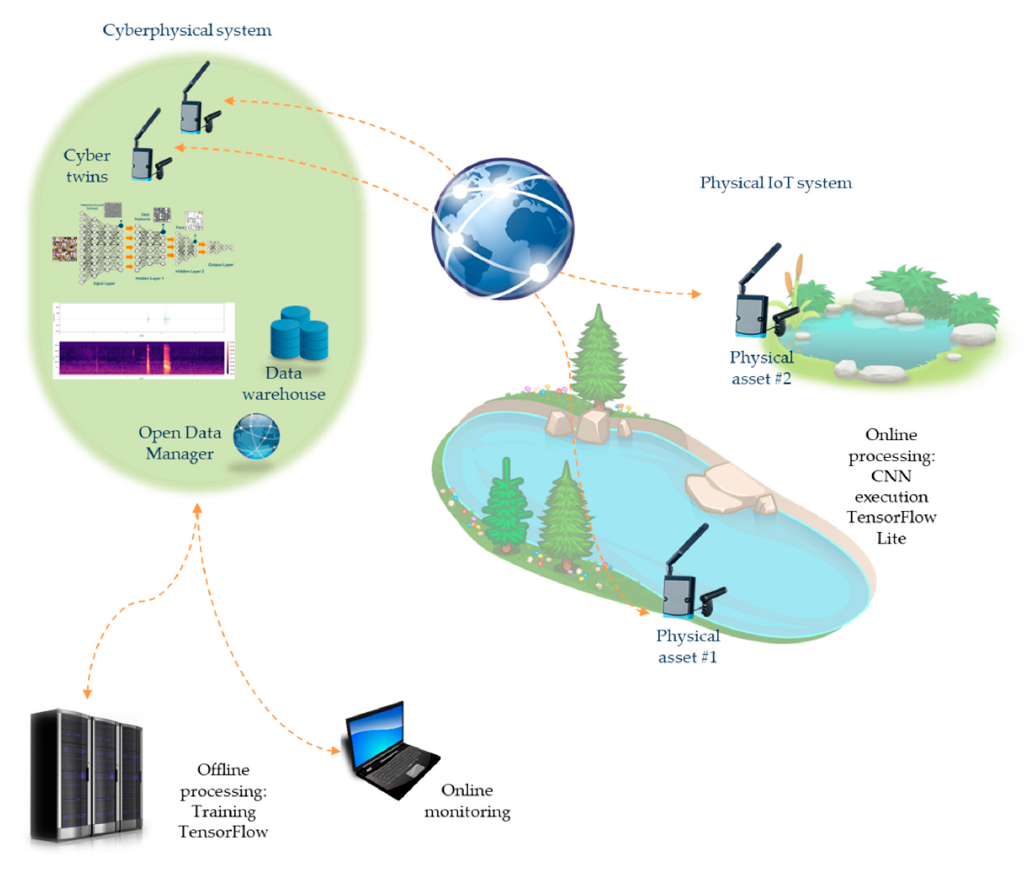
Figure 3. Main components of the CPS.